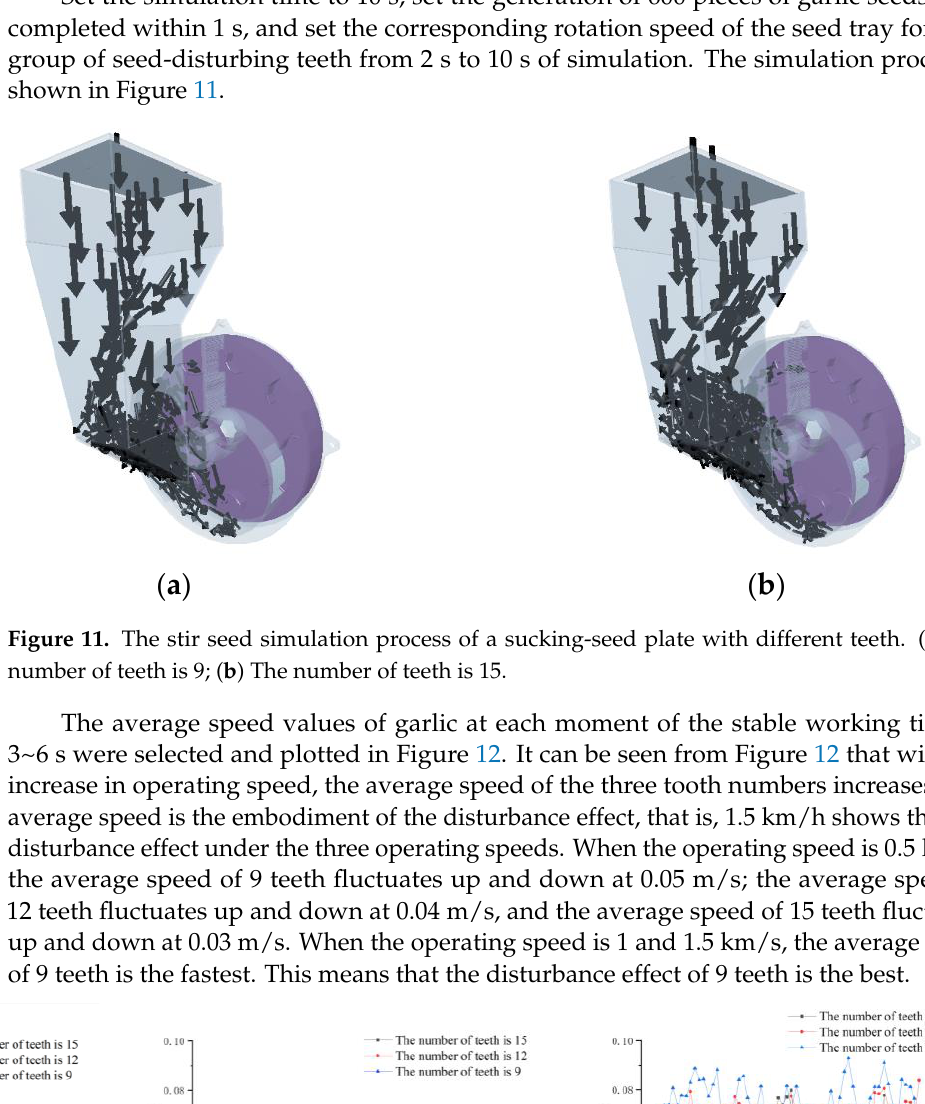
The Number of Teeth Is 15